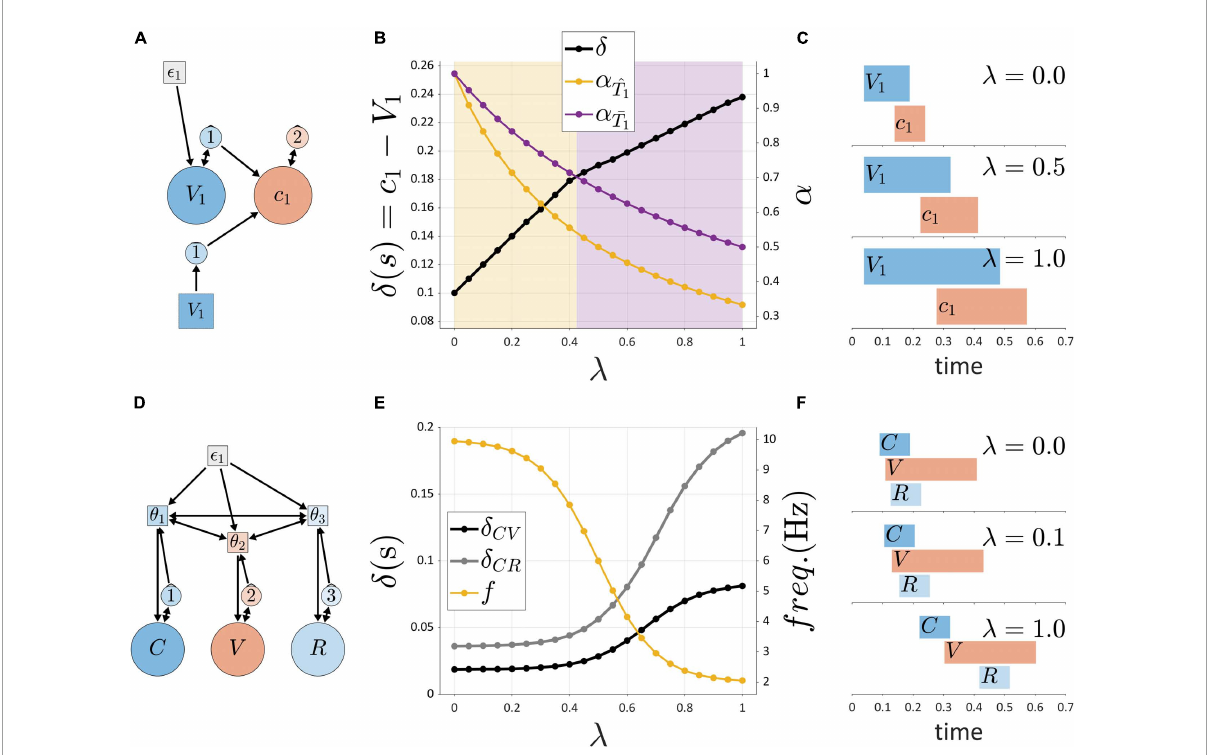
FIGURE10 Simulations of external influences on parameters. (A) Schema for post-vocalic control with both internal and external TiRs. (B) Dual axis plot showing how δ (left side) and integration rates α (right side) change with self-attention parameter λ . (C) Gestural activation intervals for several values of λ . (D) Model schema of pre-vocalic coordinative control. (E) Dual axis plot showing effect of rate parameter λ on δ -values (left side) and frequencies (right side). (F) Gestural activation intervals for several values of λ